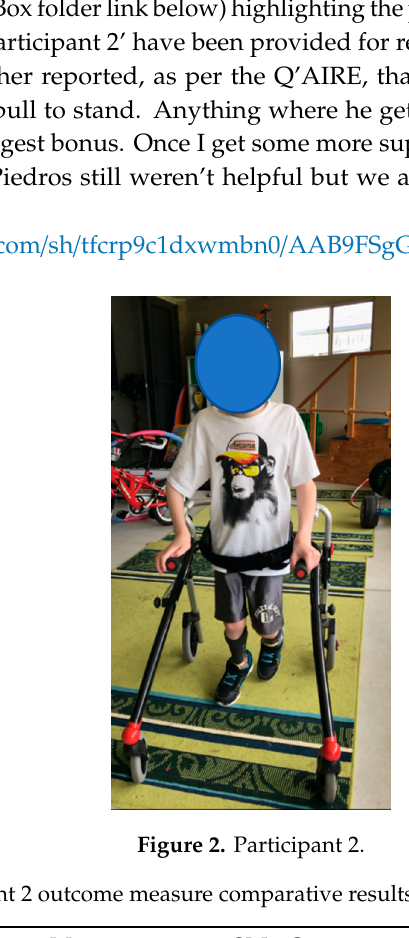
Table 2. Participant 1 outcome measure comparative results between and sensomotoric orthoses (SMotOs) and ankle–foot orthoses (AFOs).